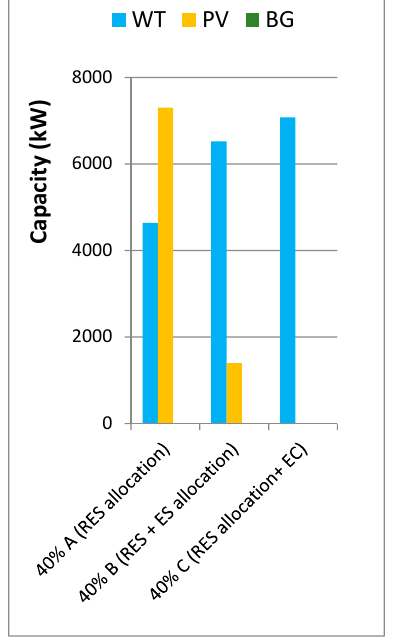
Figure 5. Structure of capacity for main scenarios—2.